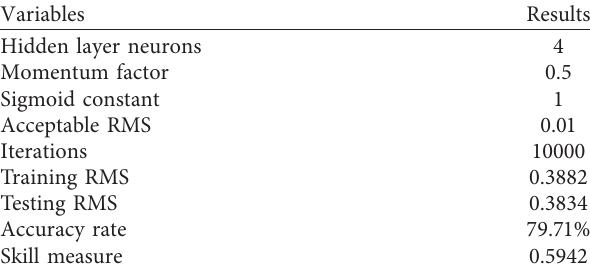
Figure 5: Geospatial partition: (a) Kernel density of land use change; (b) spatial zoning. Table 5: MLP classifier